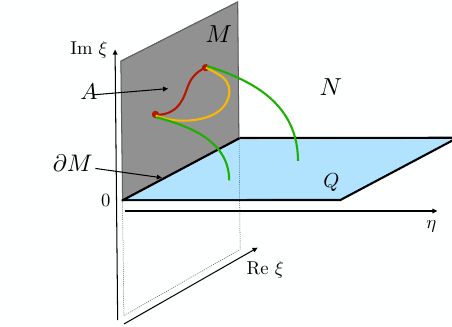
Figure 2 . A sketch of AdS/BCFT setups for AdS 3 . A holographic CFT on M (with the boundary ∂M ) is dual to gravity on N . We have ∂N = M Q and ∂Q = ∂M . The left picture shows ∪ a CFT defined on M with coordinate ( w, ¯ w ) where M has a single connected boundary, and its gravity dual. The right picture shows how it looks like in ( ξ, ¯ ξ ), where M is a upper half plane, and its gravity dual. The red curve is the subsystem A . The yellow curve and the green curve are connected geodesic and disconnected geodesic,